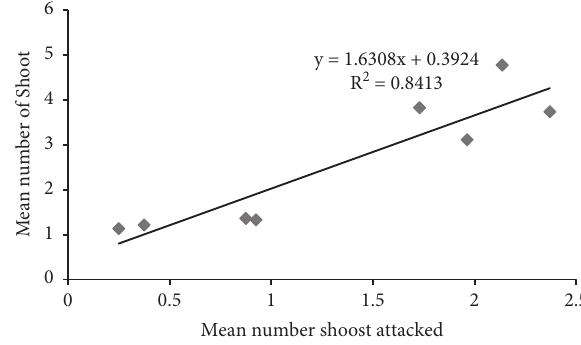
Figure 6: Relationship between the mean number of shoots and the mean number of shoots attacked for K. grandifoliola in the species trial 21 months after planting in the moist semideciduous